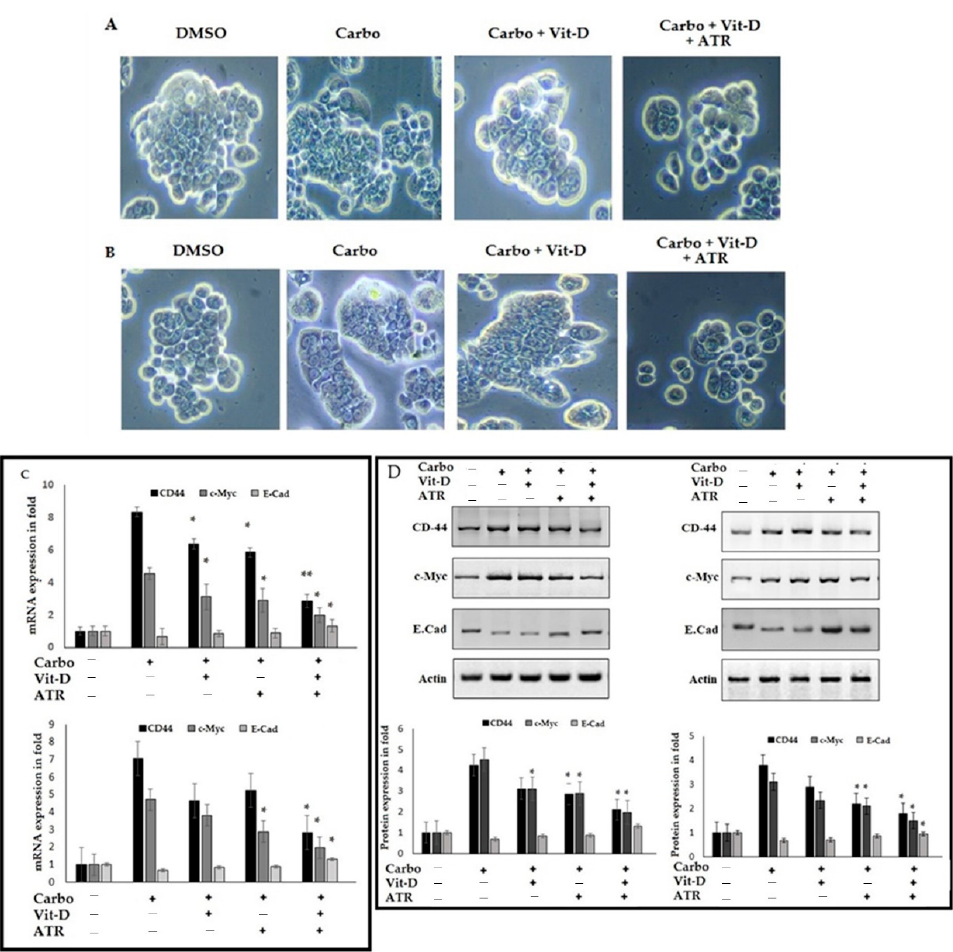
Figure 7. Effect of atropine and vit D on carboplatin-treated estrogen-sensitive and -insensitive breast cancer cells. ( A , B ) MDA-MB-231 and T47D cells were cultured in 12-well plate, induced by carboplatin (5 nM) and treated with or without vit-D- β (10 nm) supplemented with atropine (25 µ mol/L) treatments. Control cells were supplemented with 1% DMSO. The stem cell colony morphology was recorded after 4 days of treatment. The red arrow mark indicates the sphere formation, loss, gain of its epithelial structure morphology in carboplatin alone, and atropine treatment ( A , B ) The colony formation can be compared with control cell. The inhibitory effect of atropine and vit D of E-cad, CD-44, and c-Myc gene ( C ) and protein expression ( D ) of carboplatin-treated cancerous cell lines. * p < 0.05 and ** p < 0.01 (one-way ANOVA).